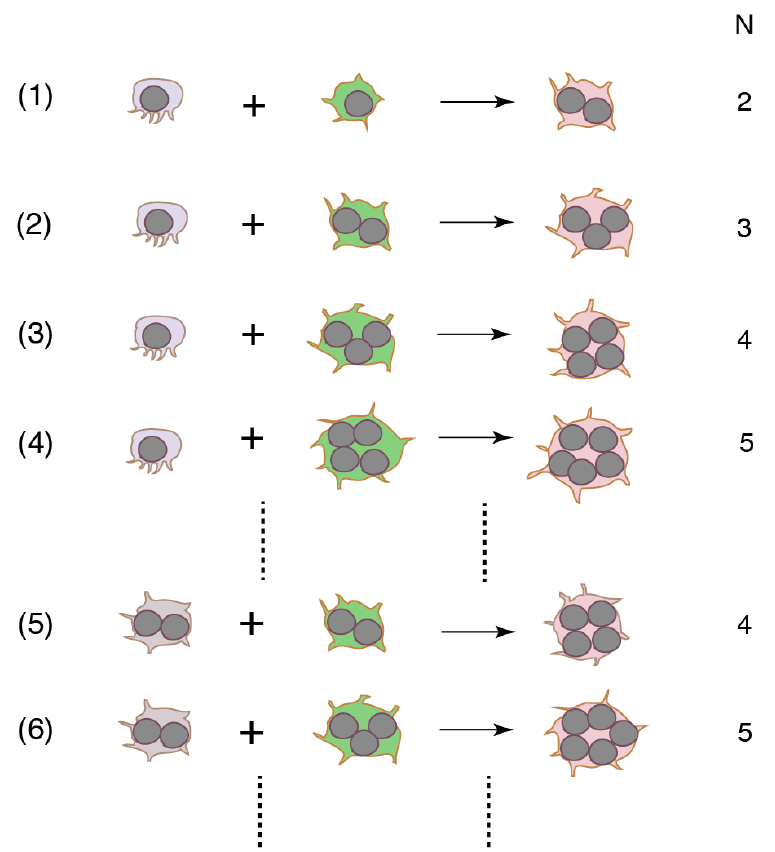
Figure 2. Distinct combinations of precursors form multinucleated cells. Because the fusion precursors are heterotypic, the precursors are coded by different colors. Although the number of nuclei in the multinucleated cells is the same, the cells may be generated by different mechanisms. N: number of nucleus in multinucleated cells after fusion.